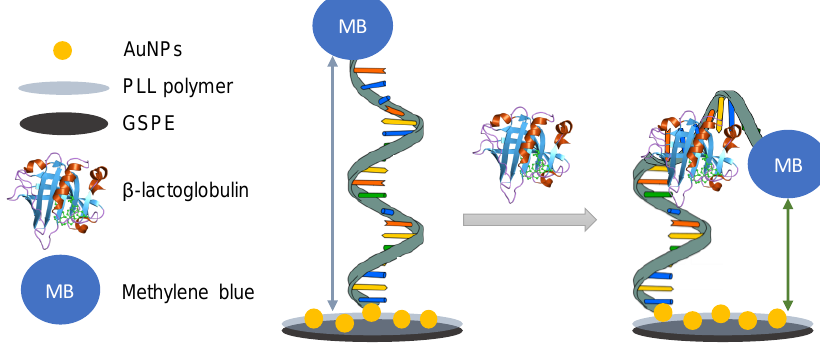
Figure 2. Schematic representation of the sensing strategy of the proposed aptasensor.